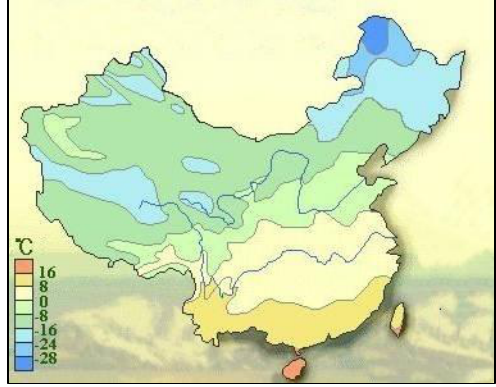
Figure 3. Average temperature map of China in January 2018.